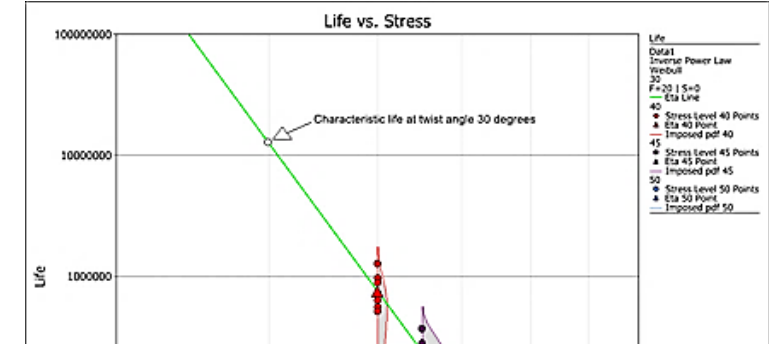
Figure 10. Probability plot rig.